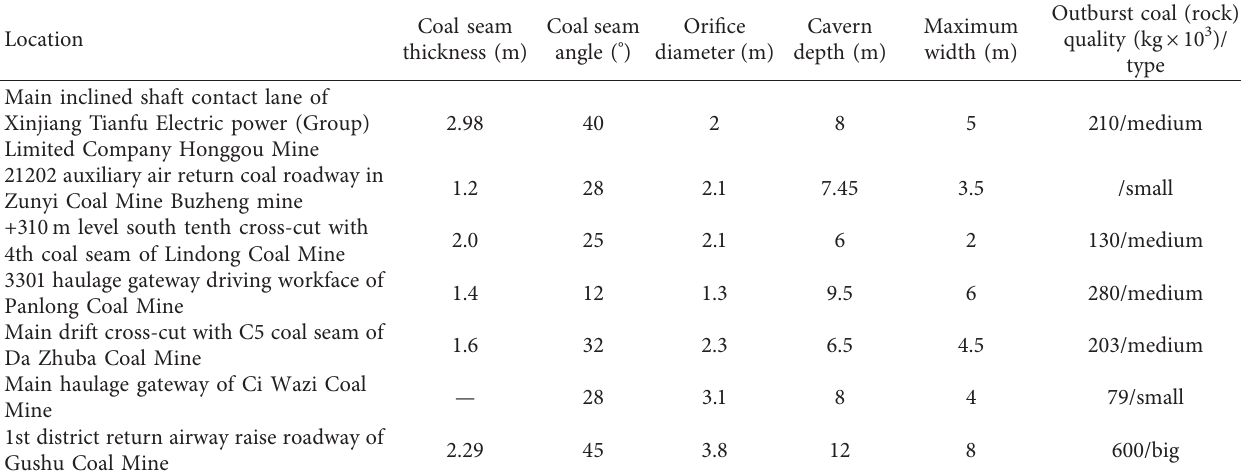
Table 2: Caverns’ geometric parameters of small and medium coal and gas outbursts.